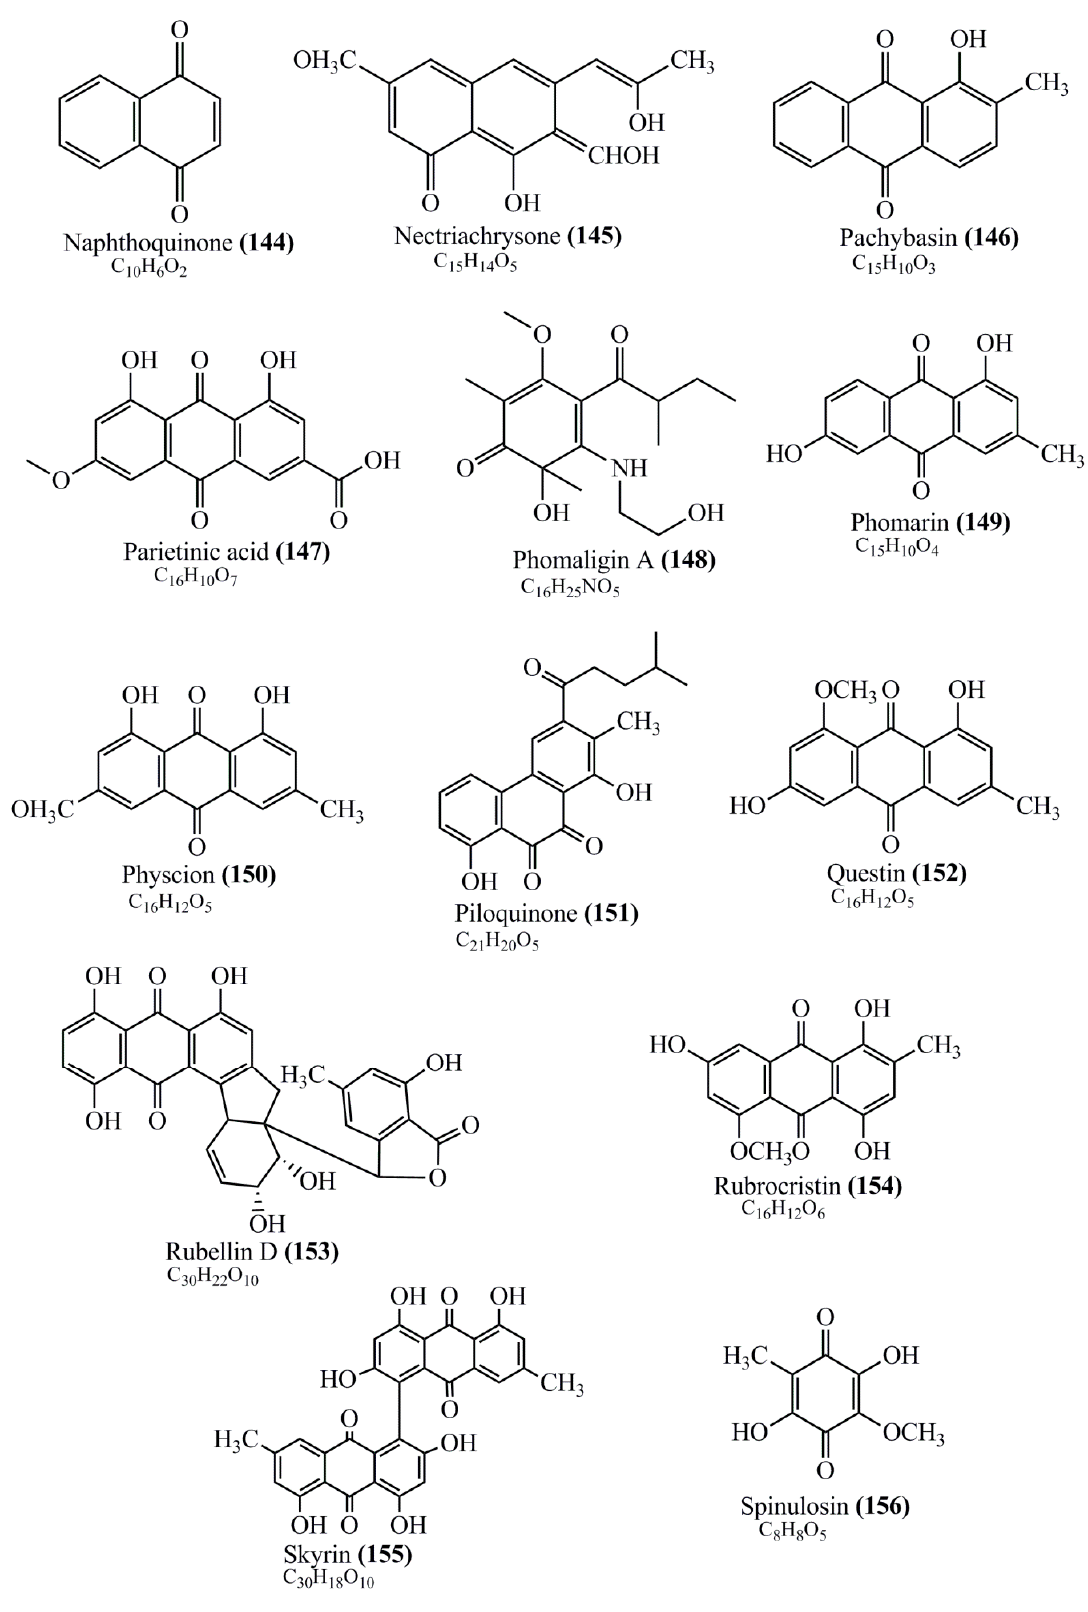
Figure 1. Continued. Figure 1.